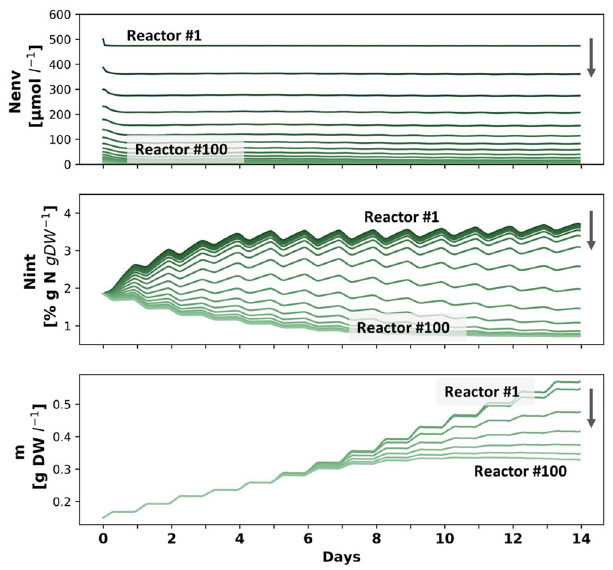
Fig. 6 N env , N int and m dynamics along a 14 days cultivation period in a diluting environment in a farm of 100 chained reactors. The lines represent N env , N int or m in each fi fth reactor, starting from x = 1 (darkest green) and progressing downstream along the arrows towards the last reactor (x = 100, lightest green). Simulation parameters and IC: spring season, N env 0 = 500 μ M-N, d =